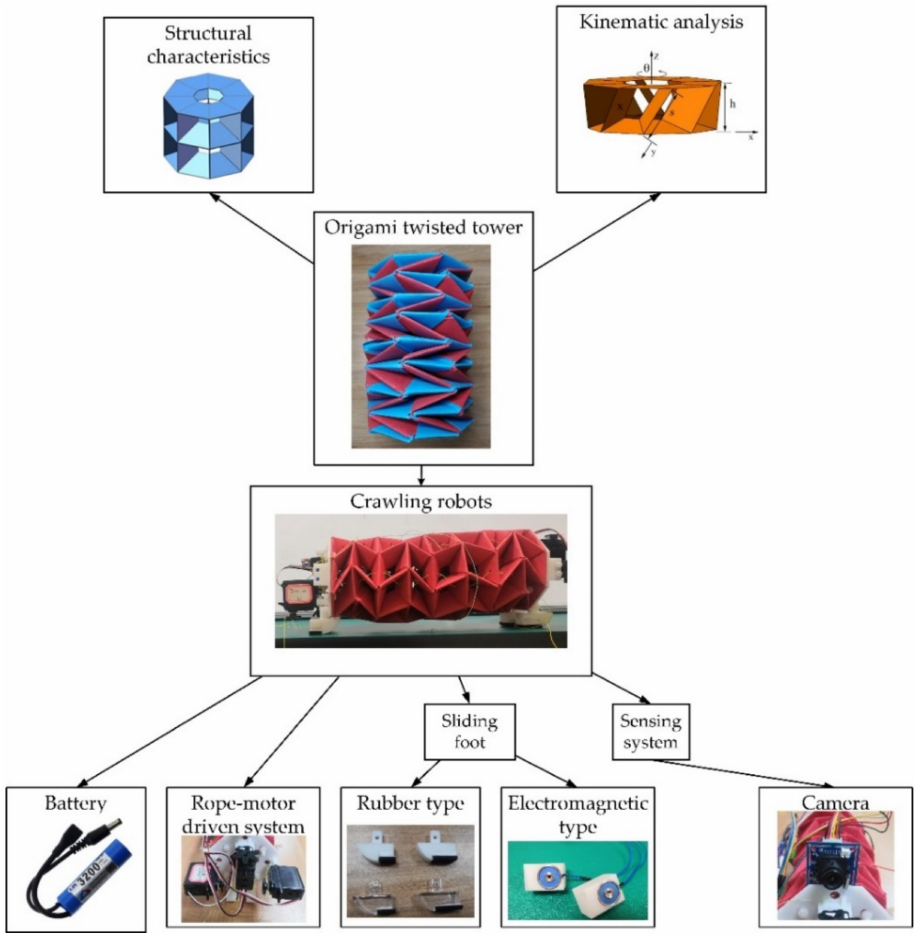
Figure 13. Design schematic of the origami crawling